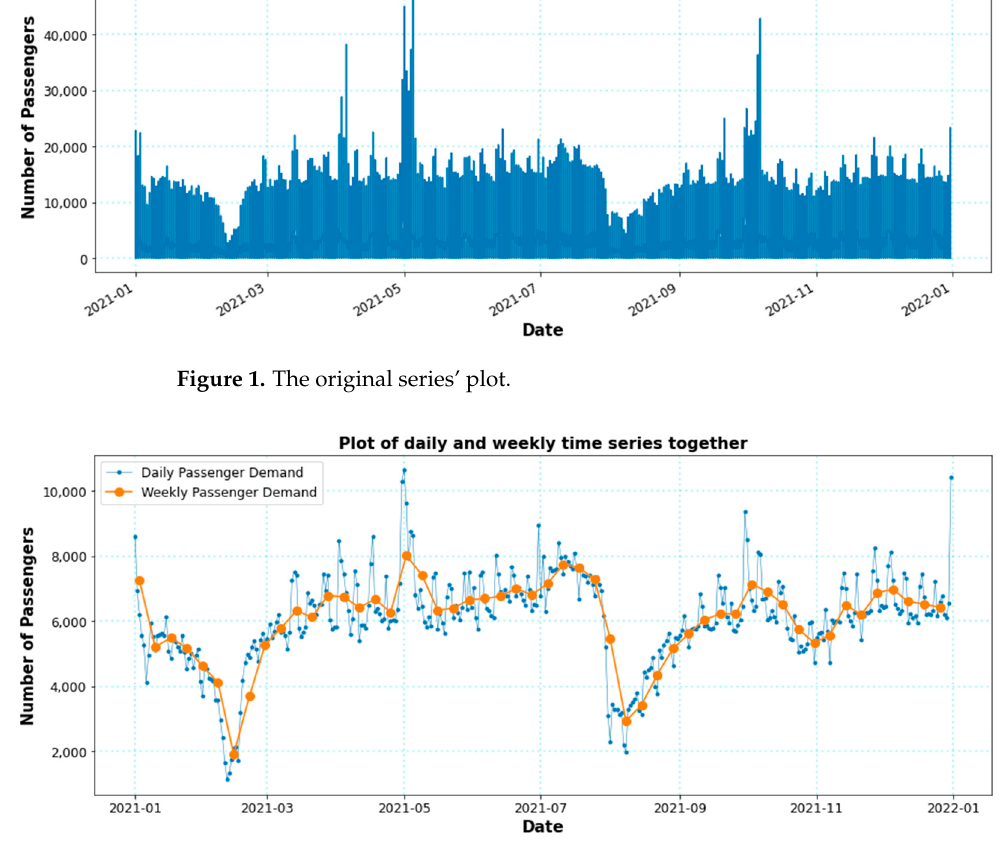
Figure 1. The original series’ plot.